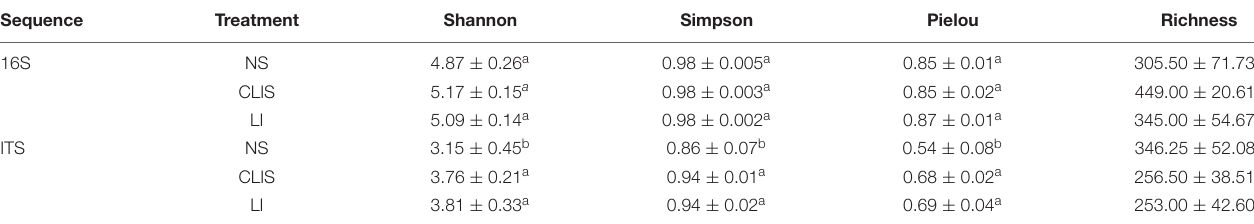
TABLE 2 | Analysis of richness (Chao1, ACE), diversity (Shannon and Simpson), and evenness (Pielou) in the 16S rRNA genes of bacteria and the ITS region of fungi, as well as the number of OTUs, observed in each treatment (NS, native savanna, LI, low-input recovering, and CLIS, crop-livestock integrated system).